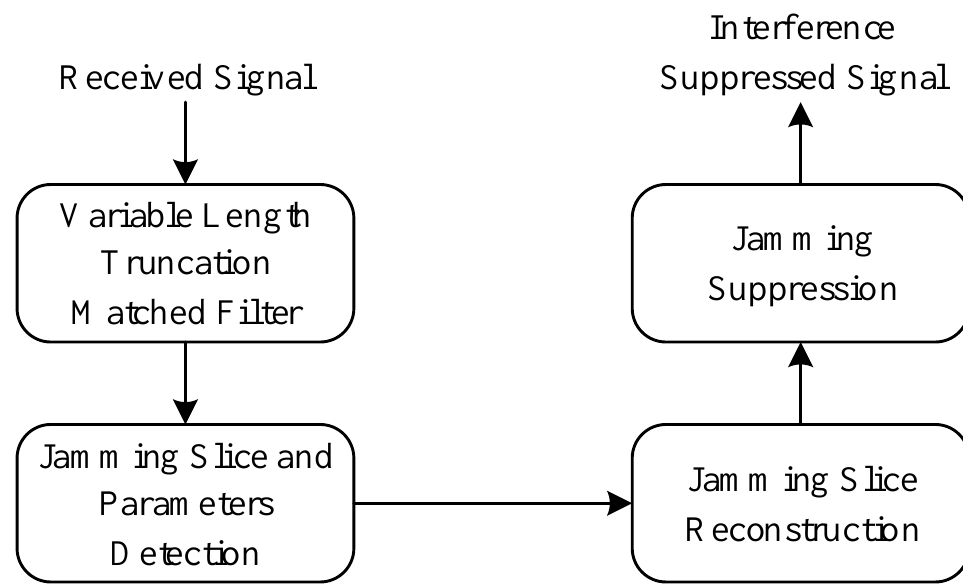
Figure 3. Flow chart of interference suppression.